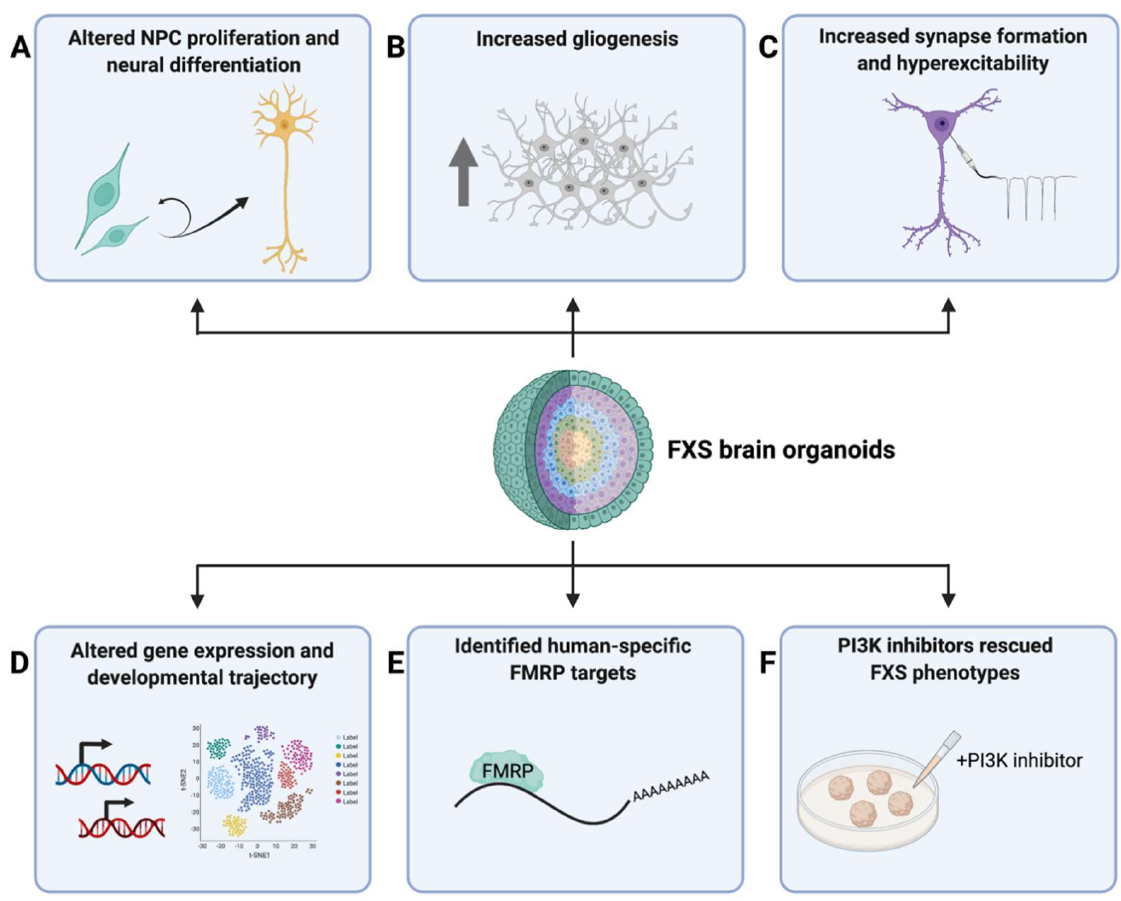
Figure 2. Summary of major findings from 3D FXS − iPSC − derived models. ( A ) FXS-iPSC-derived forebrain organoids exhibited altered NPC proliferation and neural differentiation [21,22]. In par- ticular, increased NPC proliferation was observed at differentiation day 28 [21], while reduced NPC proliferation and accelerated neural differentiation were observed at day 56 [22], suggesting a developmental-stage-specific alteration in NPC proliferation rate. ( B ) Increased gliogenesis was observed in FMRP-KO cerebral organoids [24]. ( C ) FXS-iPSC-derived forebrain organoids showed increased synapse formation and hyperexcitability at differentiation day 56 [22]. ( D ) Transcriptome analysis revealed alterations in gene expression profile and cell-type-specific developmental trajectory in FXS-iPSC-derived forebrain organoids [21,22]. ( E ) Using human forebrain organoid models, a large number of human-specific FMRP targets were identified via eCLIP-seq [22]. ( F ) PI3K inhibitors were able to rescue FXS phenotypes in forebrain organoids